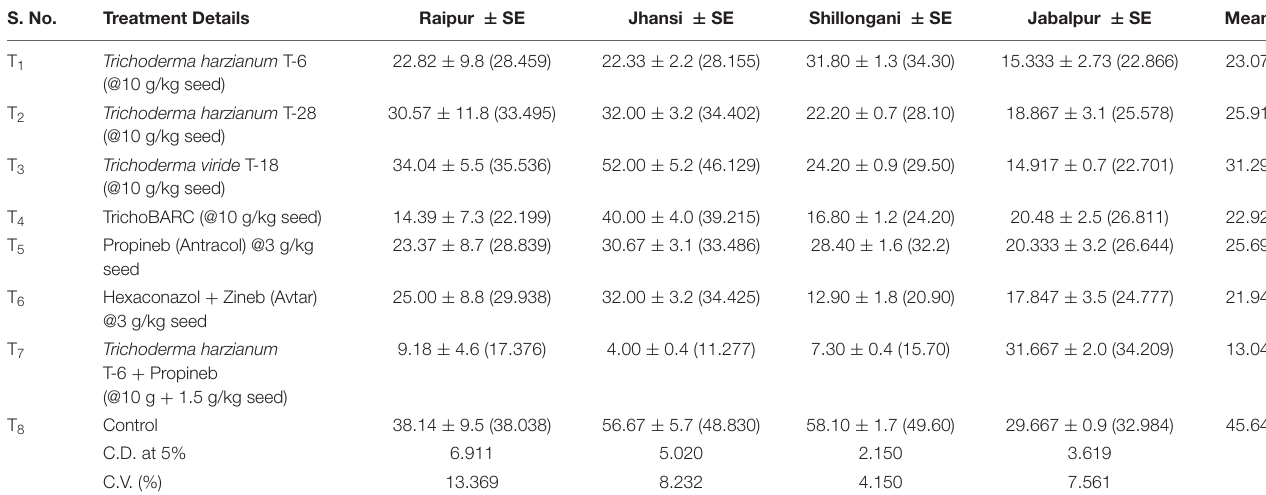
TABLE 3B | Evaluation of new stains of Trichoderma along with fungicides for the management of collar rot of chickpea (2018–2019) – Disease incidence (%). S. No.